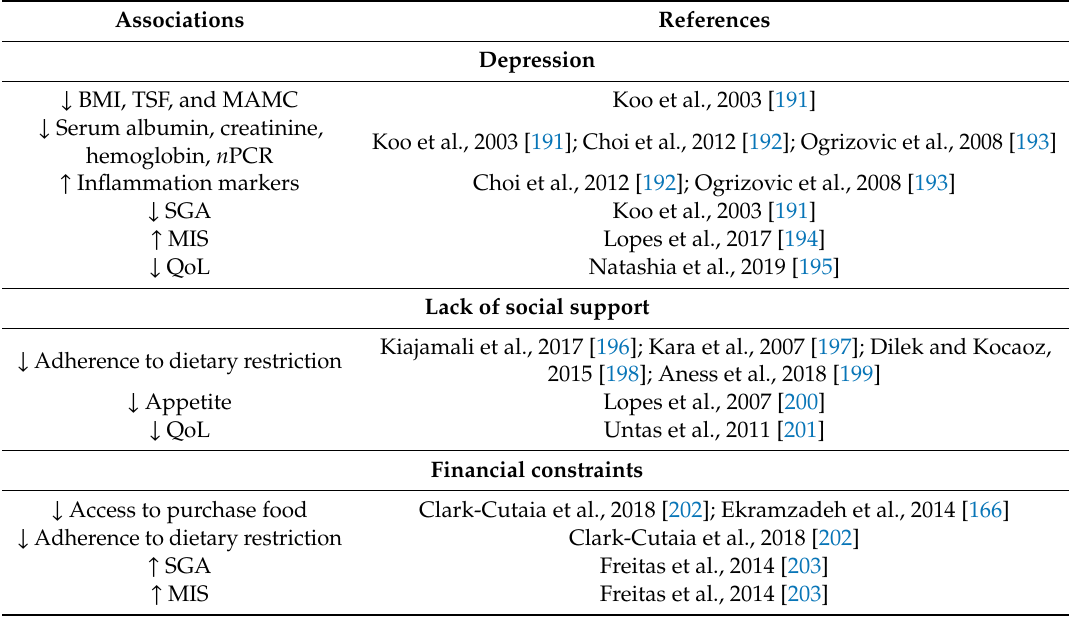
Table 8. Impact of psychosocial factors on nutritional